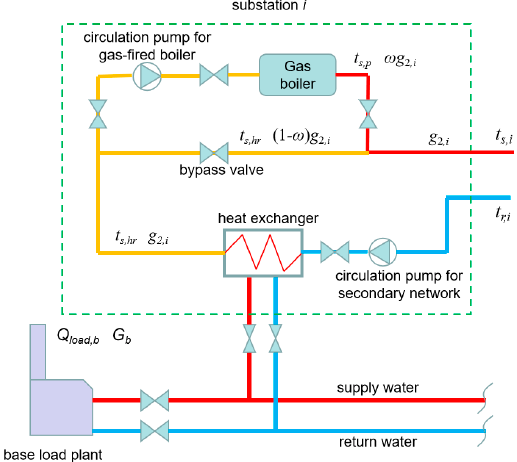
Figure 1. DH system with gas-fired PBs in all heating substations with series connection modes .